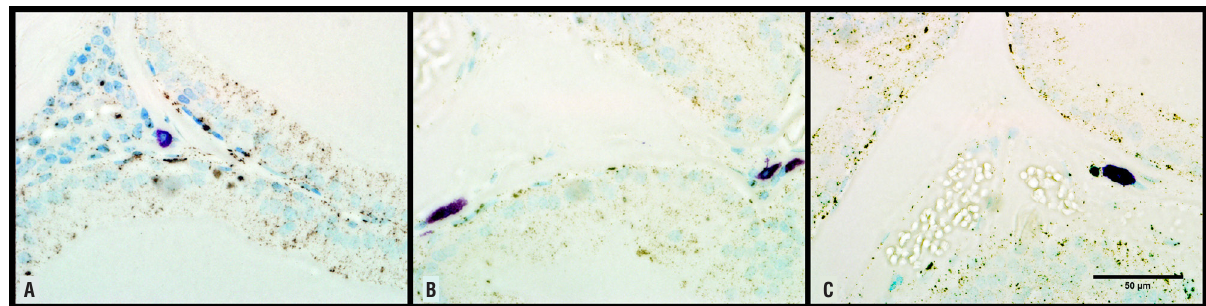
Figure 1 - Ventral prostate of rats stained with toluidine blue and observed 600X magnification. In image A) we observe normal quantity of mast cells (0.45±0.07) per field. In image B) (group Orch) we observe an increase on the number of mast cells per field (2.83±0.25), which returned to normal (0.52±0.14) in animals receiving hormonal replacement as seem in image C) (group Orch+T).